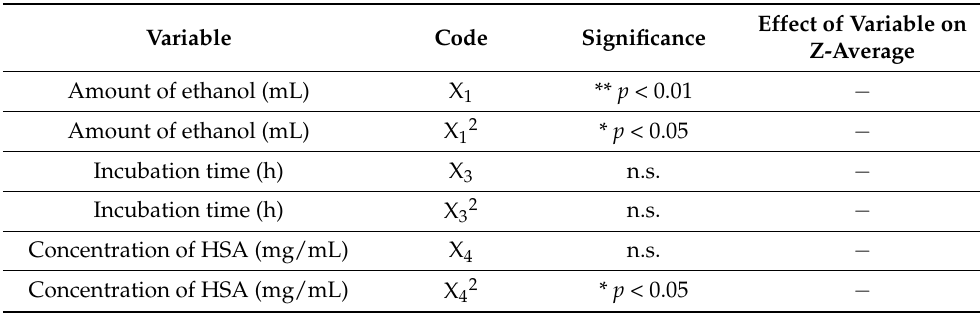
Table 9. Effect of the selected process and material parameters on the Z-average of HSA nanoparti- cles produced by the rapid coacervation method. Statistical analysis: One-way ANOVA, α = 0.05. (* p < 0.05; ** p < 0.01 significant, while n.s. means non-significant effect). Variable Code Significance